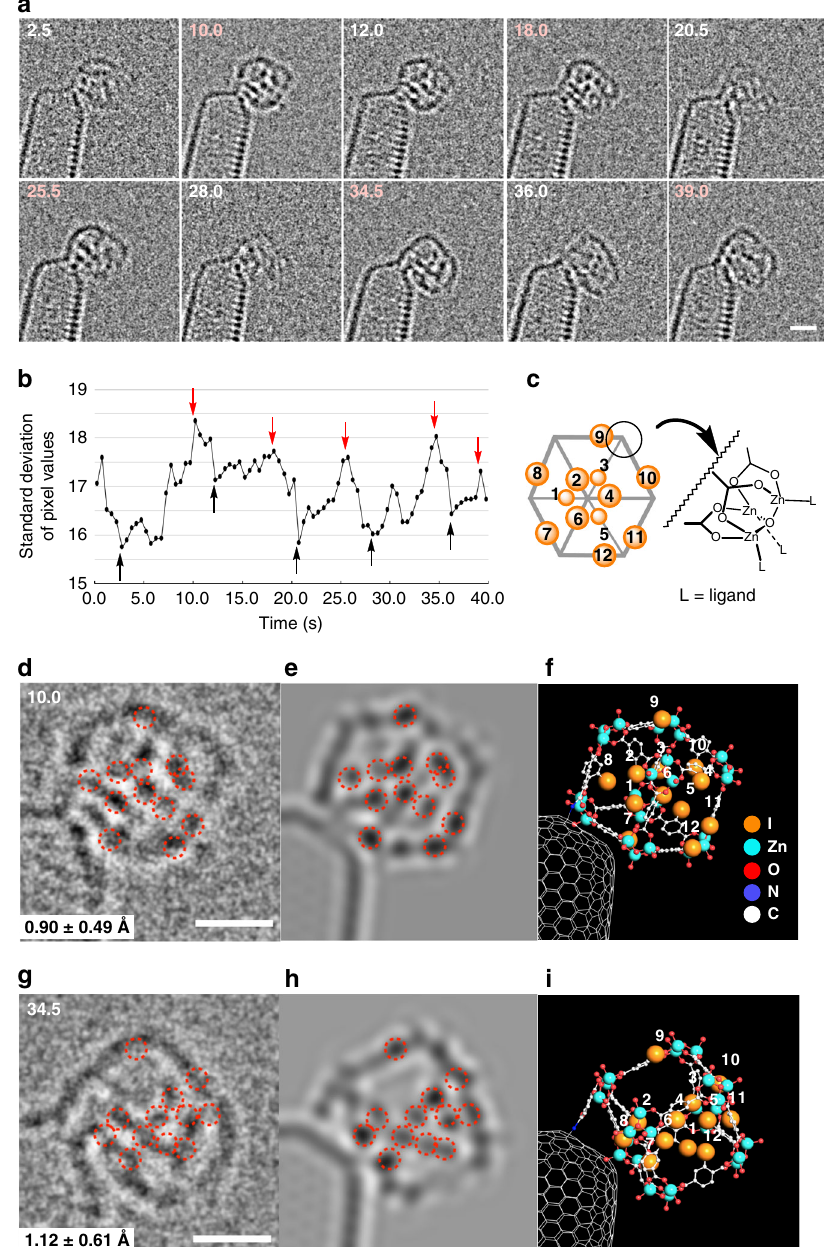
Fig. 6 TEM imaging and structure assignment of PNCs in I-MOF-5 synthesis at 0.01 M of Zn 2 + for 21 h. a Ten SMART-EM images out of 80 video frames of a cubic PNC made of IBDC rotating in a stochastic manner (methanol wash). The original video is Supplementary Movie 6. b Time-dependent change of the standard deviation of the pixel values in the video frames. Five high contrast frames, shown in a , are indicated by red arrows and fi ve low contrast frames by black arrows. c A model structure of the cubic PNC at 10.0 s, where the 12 iodine atoms are numbered and their positions in 2-D projections are highlighted. d An isometric projection of the cube at 10.0 s, where 12 spots of iodine atoms are highlighted by red circles. e A simulated image and f a Z2A model corresponding to e . g A dimeric projection at 34.0 s, h simulated image, and i Z2A model corresponding to h . Figures c , f and i share the same numbers for assignment of the 12 iodine